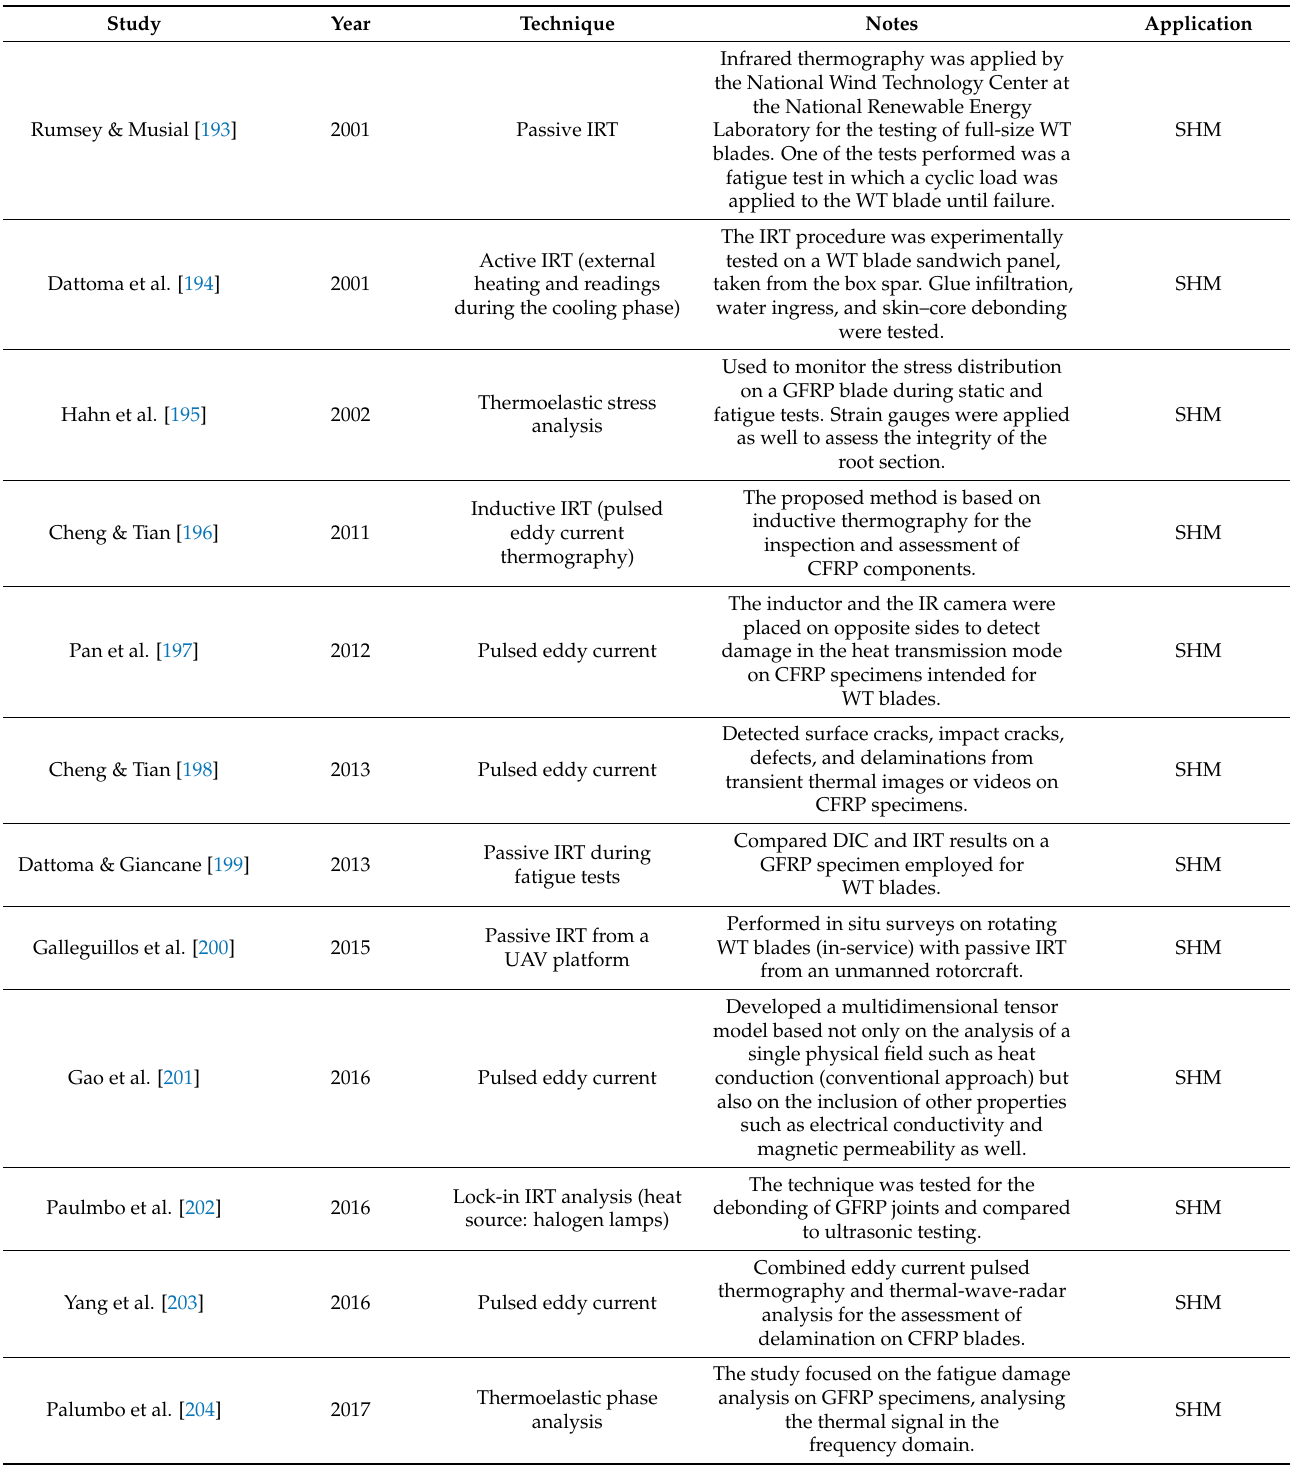
Table 7. Some notable and recent examples of IRT techniques applied for the NDE of wind